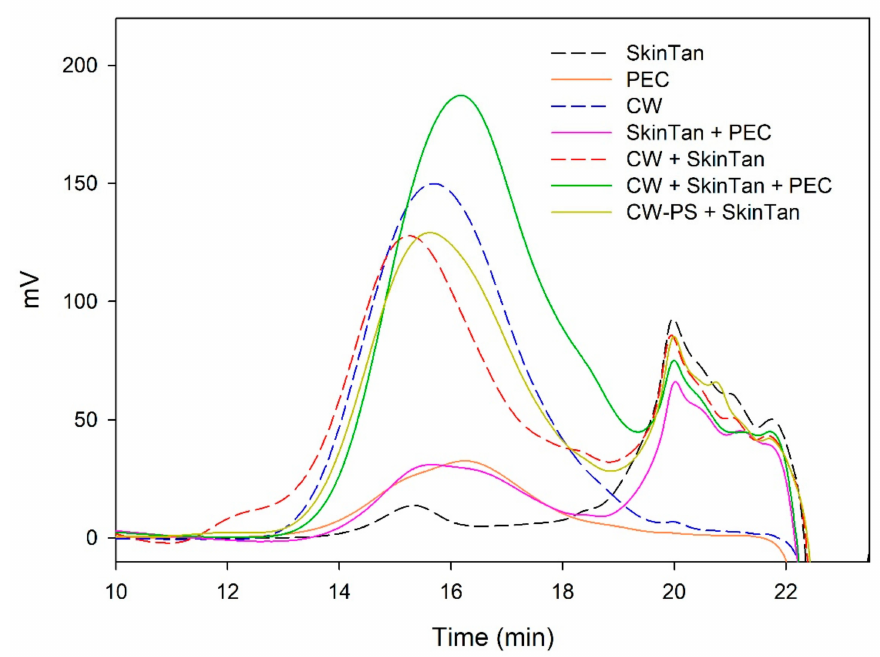
Figure 5. Analysis of the mass distribution of polysaccharides by SEC. Comparison of the polysaccharides released in the interaction tests between SkinTan, PEC, CW, and